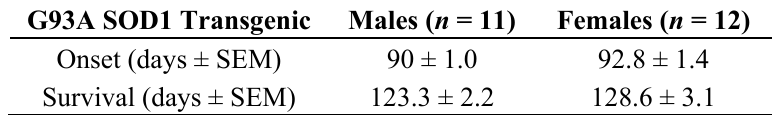
Table 2. Gender effects on disease onset and survival in amyotrophic lateral sclerosis (ALS) mice.